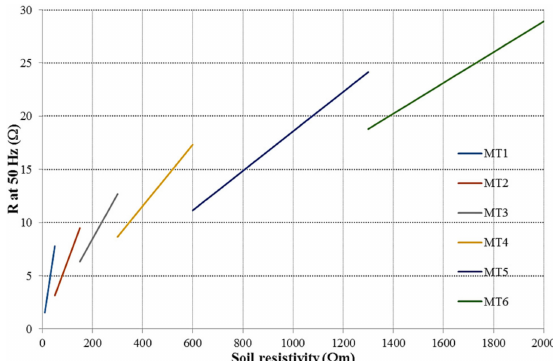
Figure 11. Calculated values of the grounding resistance at power